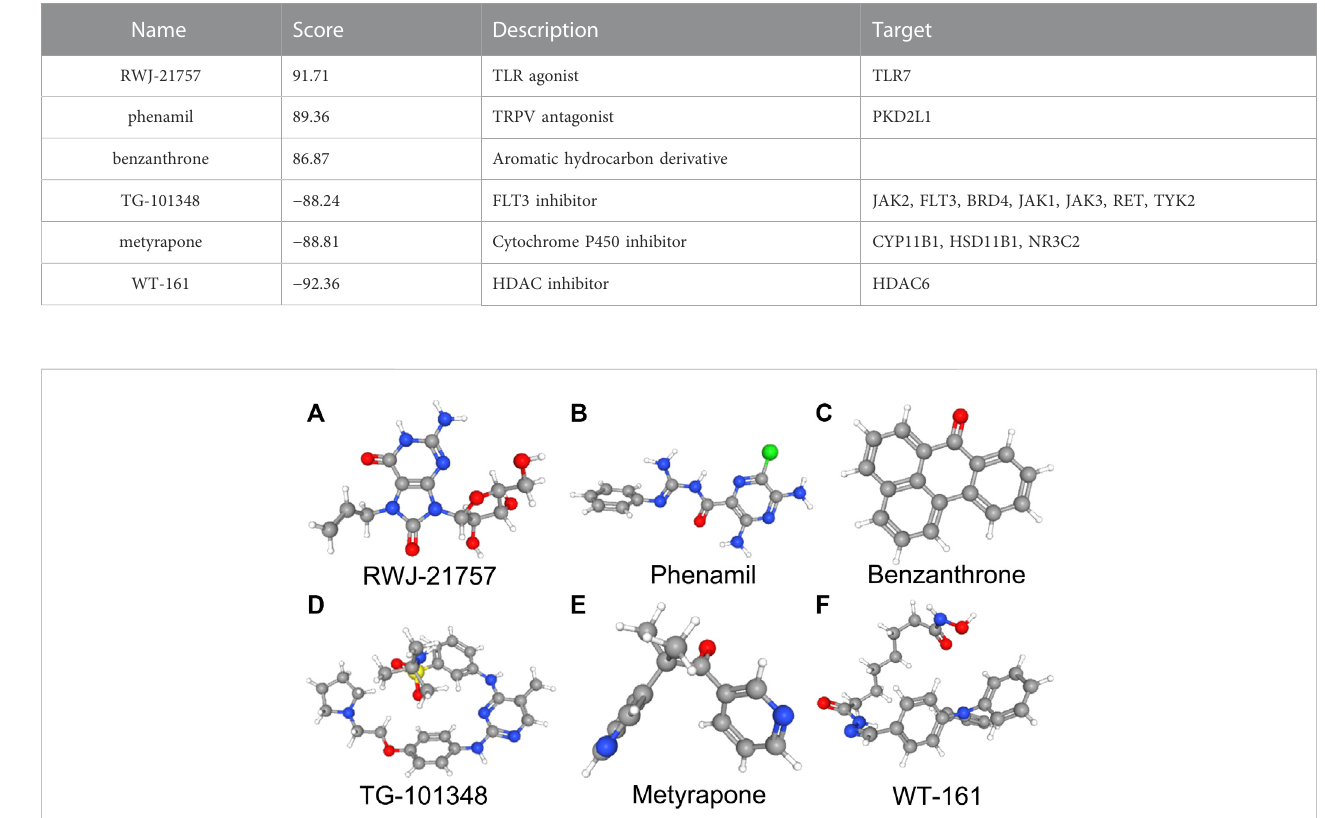
FIGURE 7 3Dstructures ofsmallmolecularcompounds.Torevealthepromisingcompounds,300DEGsweresubmittedtoConnectivity Map(CMap)(https://clue. io/), and the cutoff criterion (0.8 < |connectivity score| < 1 and p < 0.05) was used. Top 6 small molecular compounds with highest enrichment score were identi fi ed as promising drugs that may have potential therapeutic effects against